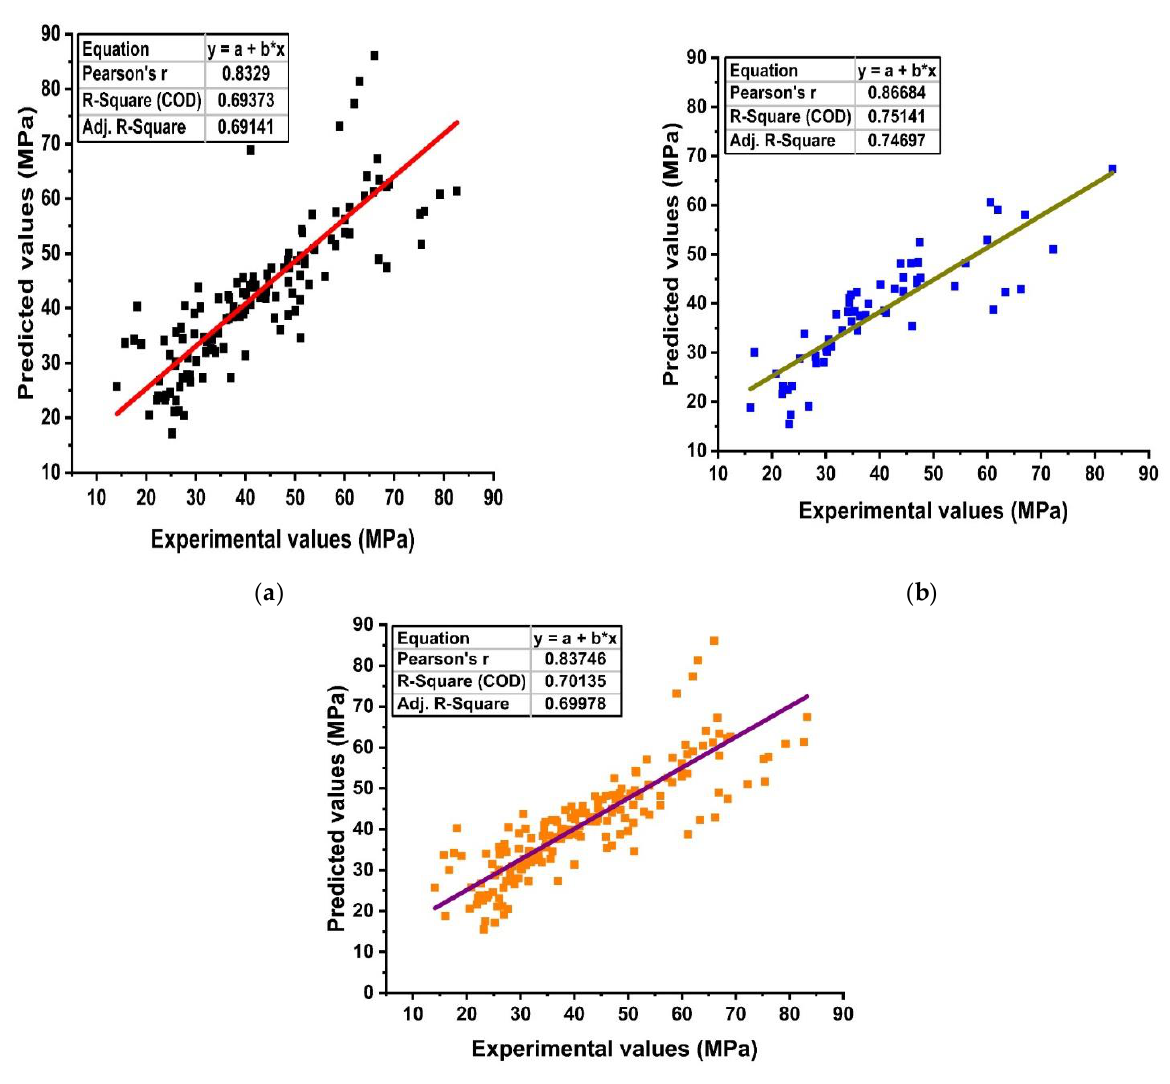
Figure 8. MNLR ( a ) training, ( b ), validation, ( c ) testing.